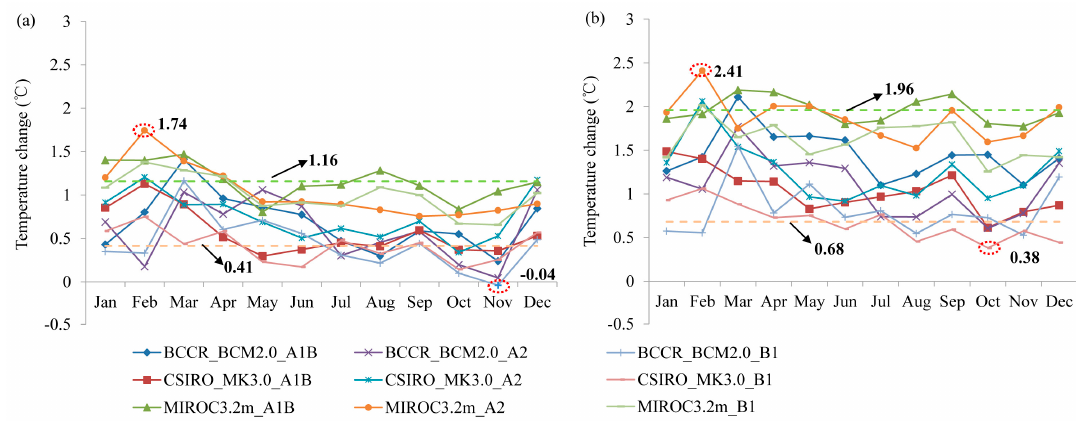
Figure 5. The forecasted temperature differences relative to 1980–2004 period under CMIP3: ( a ) the period 2016–2040; ( b ) the period 2041–2065.